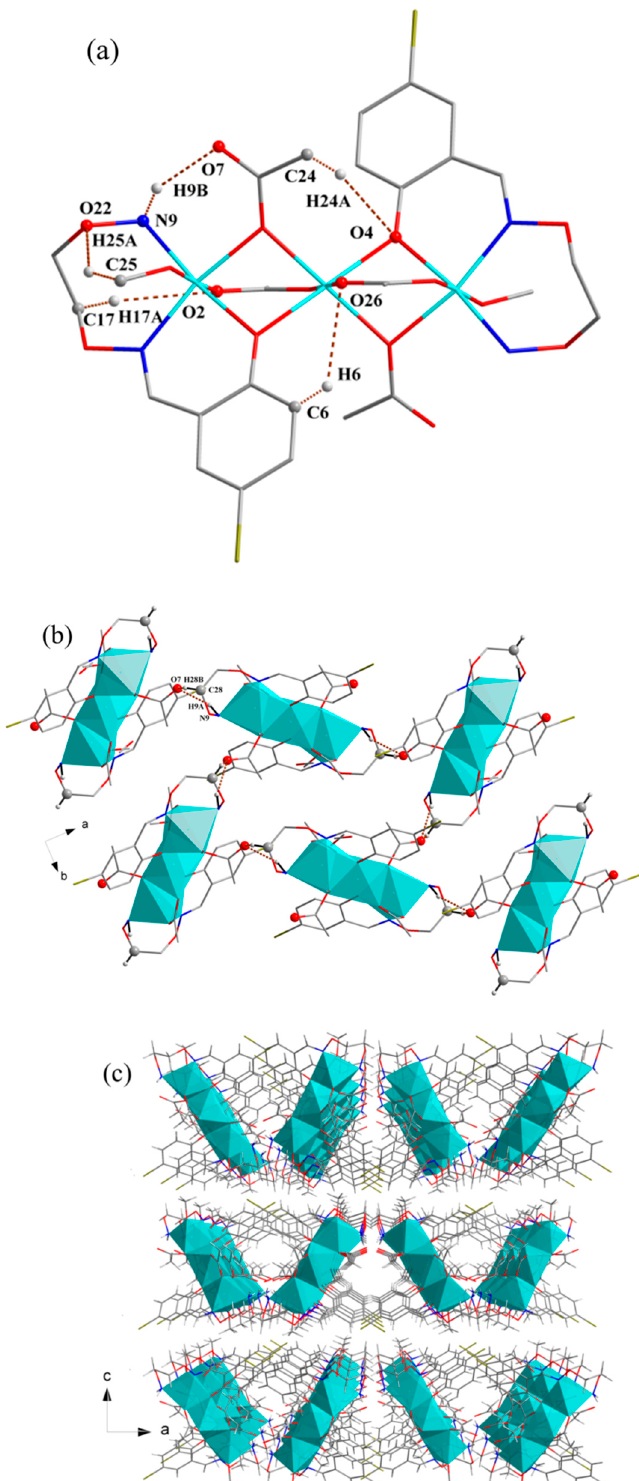
Figure 3. ( a ) View of the intra-molecular hydrogen bonding interactions of the Ni(II) complex (hydrogen atoms are omitted for clarity, except those forming hydrogen bondings); ( b ) View of the 2D supra-molecular structure of the Ni(II) complex; ( c ) view of the 3-D supra-molecular structure of the Ni(II) complex. Table 4. Hydrogen bonding interactions (Å, ) of the Ni(II) complex.